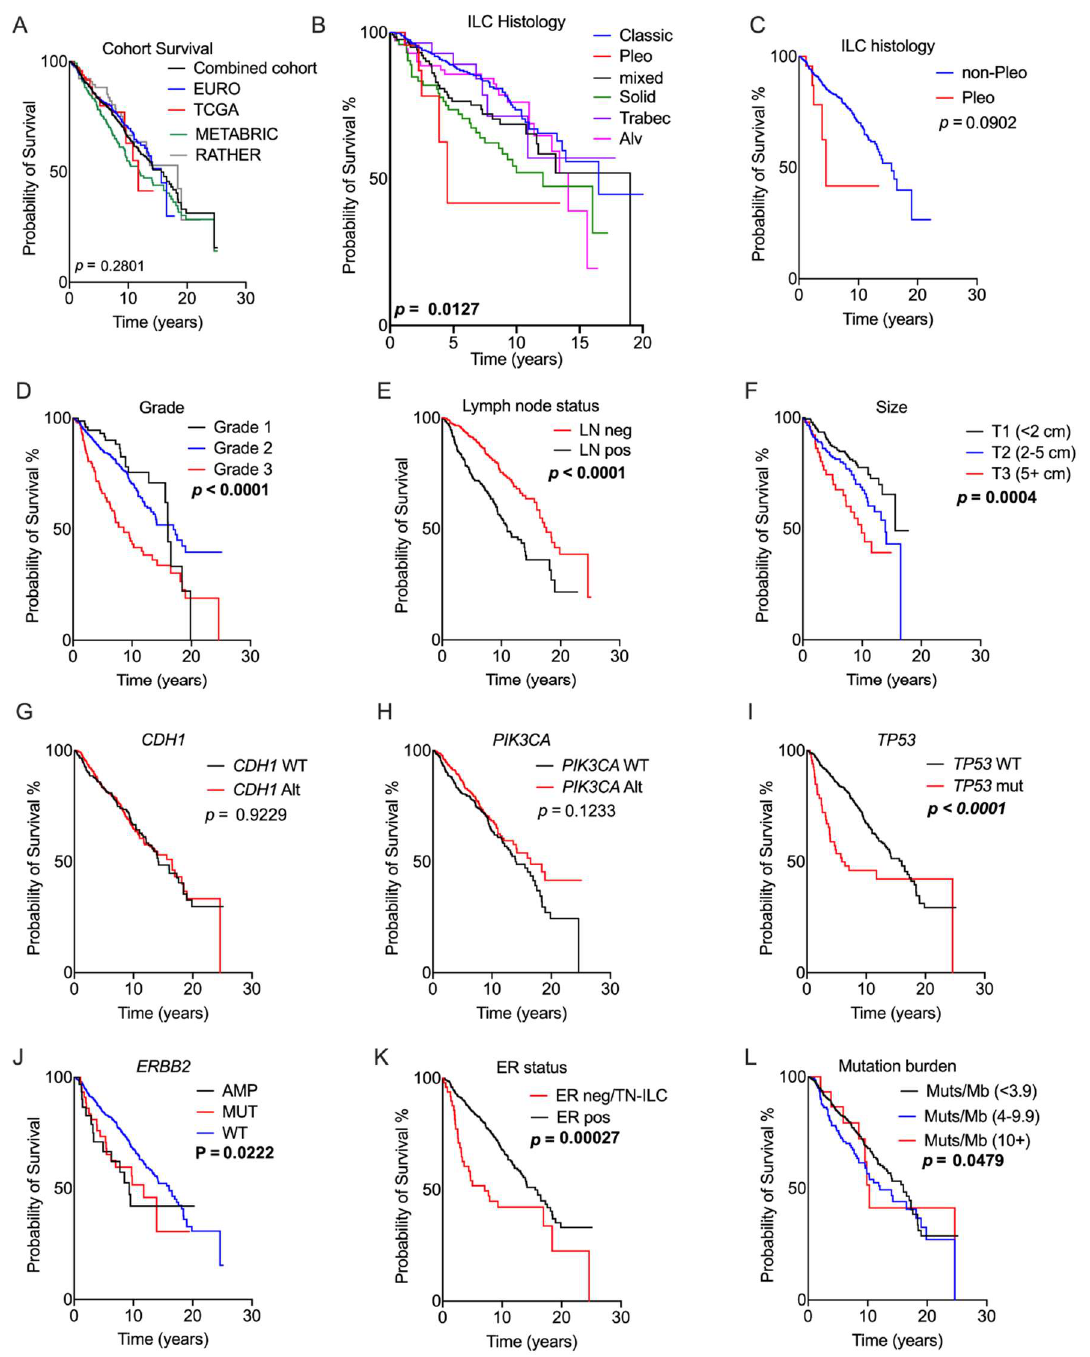
Figure 2. Association of genomic and pathology features with prognosis. Kaplan–Meier curves measuring survival associations of the following features: ( A ) overall survival; ( B ) ILC histology; ( C ) pleomorphic histotype; ( D ) grade; ( E ) lymph node status; ( F ) tumour size; ( G ) CDH1 gene status; ( H ) PIK3CA gene status; ( I ) TP53 gene status; ( J ) ERBB2 gene status; ( K ) ER status; and ( L ) tumour mutation burden expressed as mutations/Mb. The RATHER data were included for this analysis with the exception of ( L ). Abbreviations: Alt = any genetic alteration; Alv = alveolar; AMP = amplification; LN = lymph node; MUT = mutation; neg = negative; pleo = pleomorphic; pos = positive; TN-ILC = triple-negative ILC; trabec = trabecular; and WT = wild type. Significant p -values (log-rank test) are noted in bold.